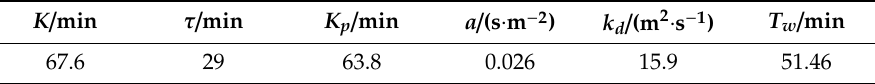
Table 2. Delay time calculated by four algorithms.